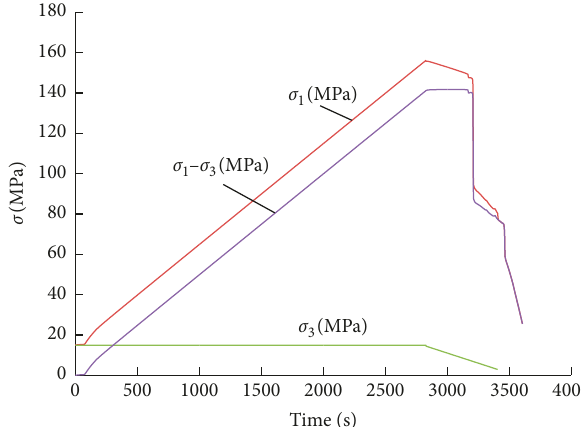
Figure 2: Curves of ( σ 1 – σ 3 )-time, σ 1 -time, and σ 3 -time of the specimen ( σ 3 � 15MPa).